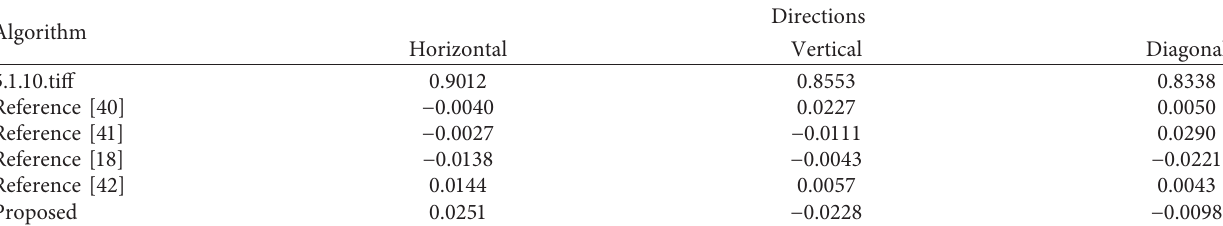
Table 15: Comparison